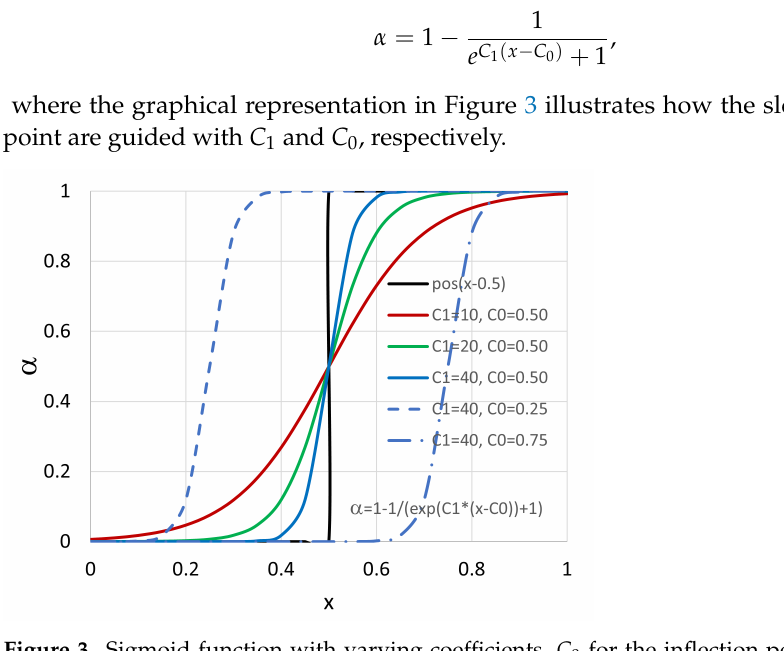
Figure 3. Sigmoid function with varying coefficients, C 0 for the inflection point shift (full, dash, dash–dot) and C 1 for modifying the slope (red, green, blue), and step function